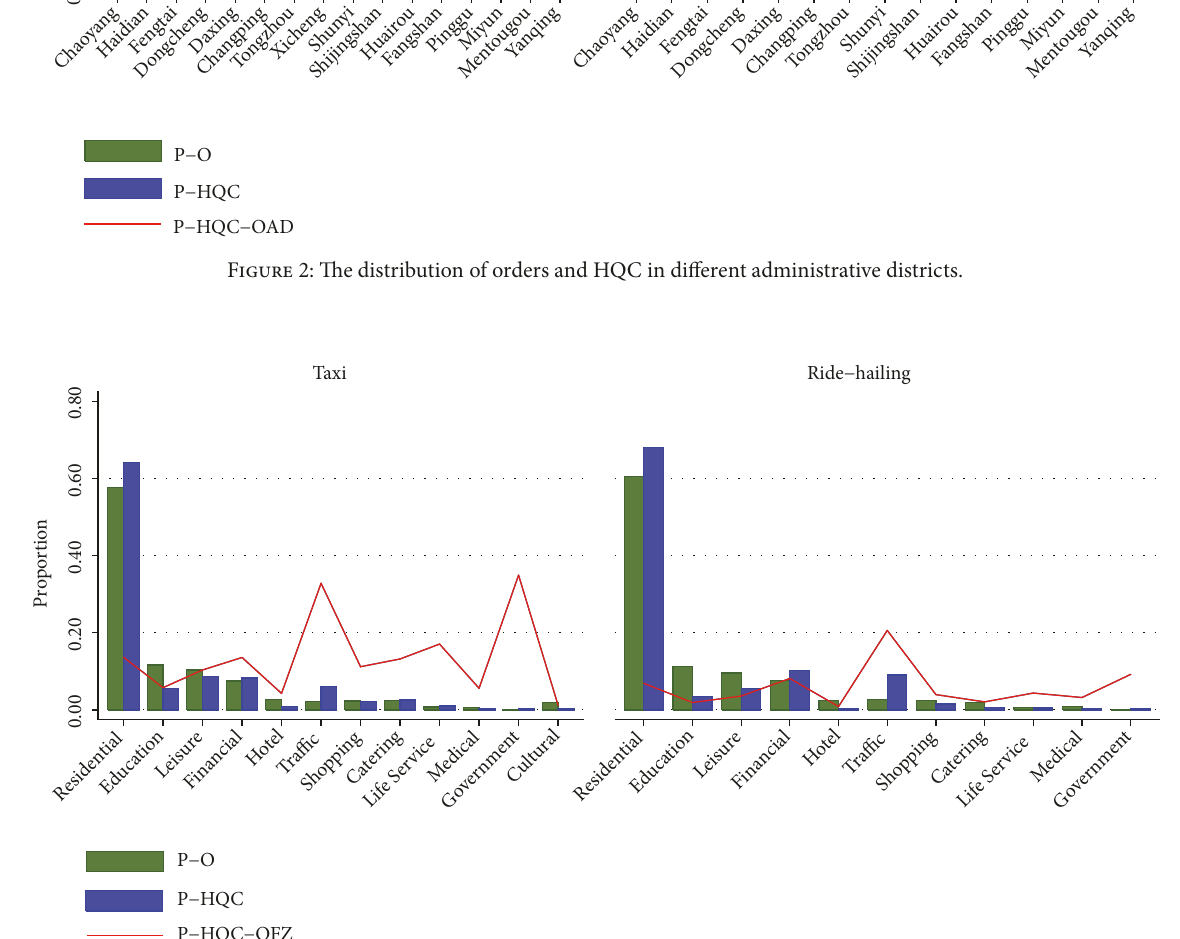
Figure 3: The proportion of orders and HQC in different functional